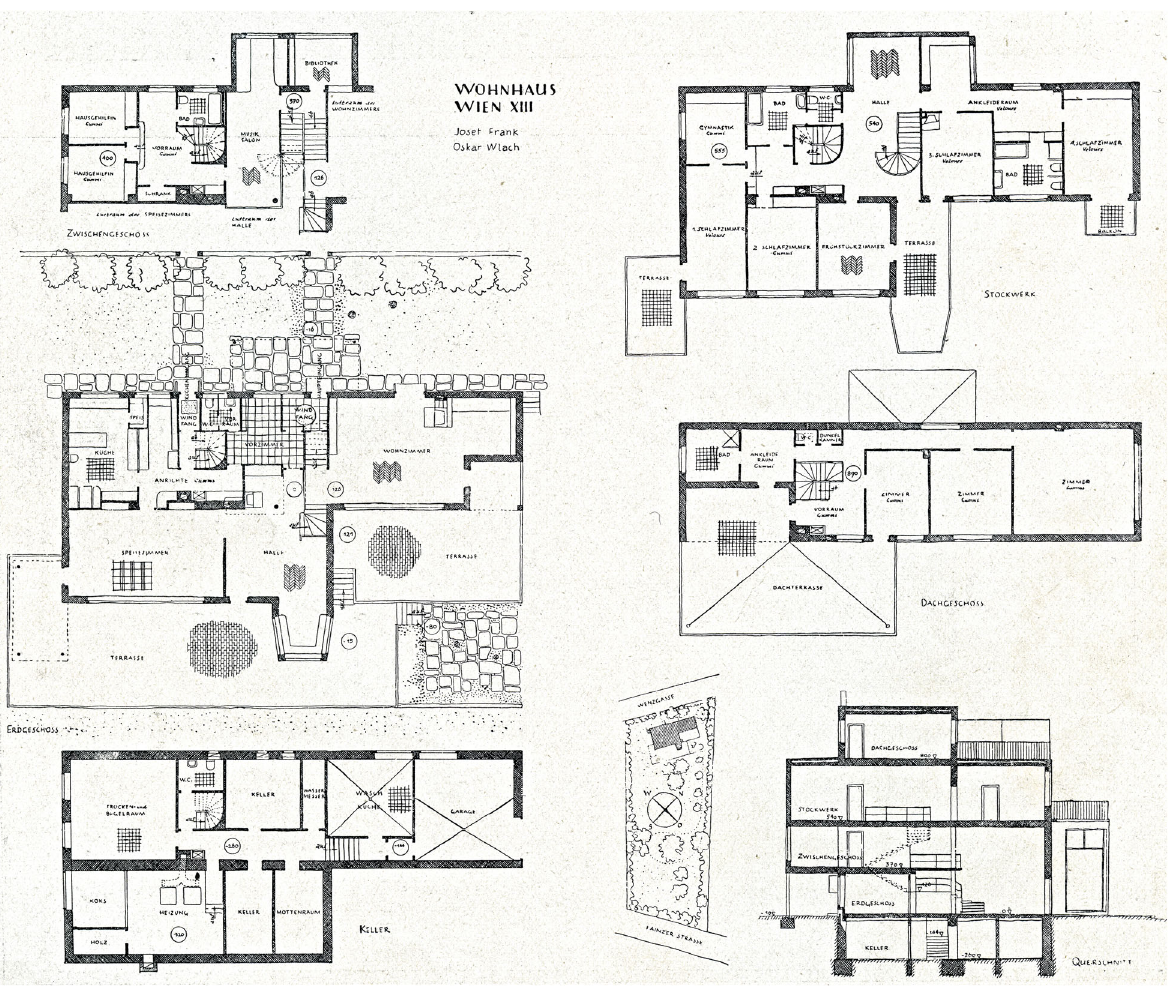
Fig. 3 Villa Beer, Vienna-Hietzing, 1930, publication plans, (Source: Innendekoration 42,1931,